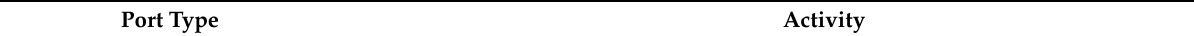
Table 3. Types of ports.